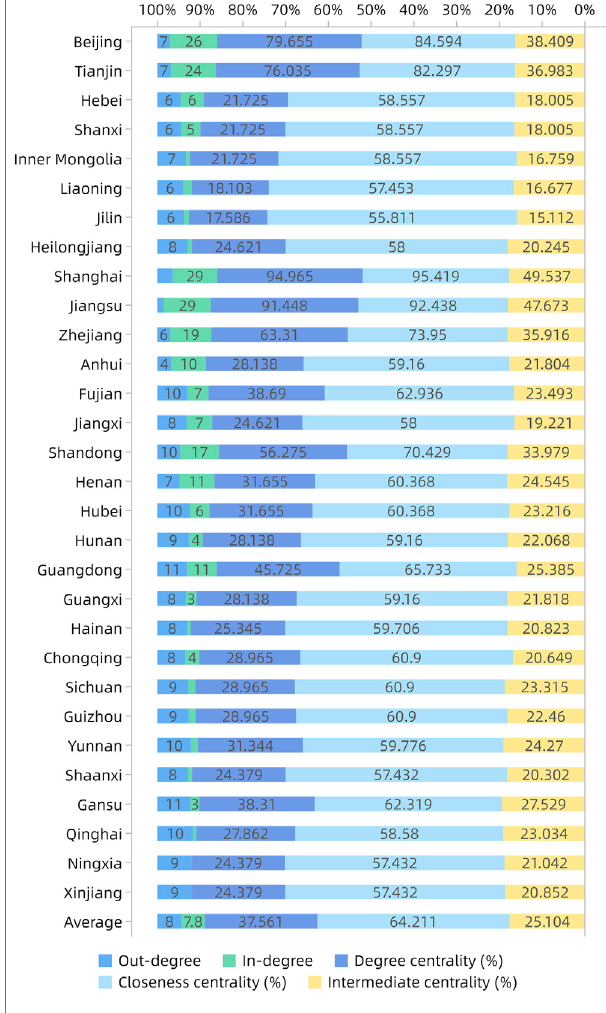
( Figure 3 ). From 2008 to 2010, the network hierarchy degree dropped signi fi cantly, which indicates that the mutual effect among provinces in the network was gradually strengthened.